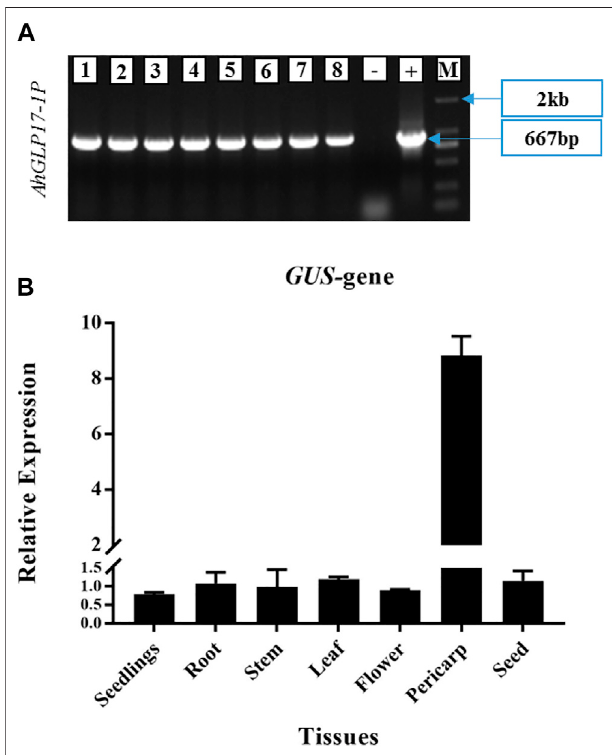
FIGURE 5 | (A) Con fi rmation of T0 transgenic Arabidopsis plants transformedwith AhGLP17-1P (667 bpfragment).Eighthygromycin-resistant plants veri fi ed by PCR ampli fi cation with promoter-speci fi c forward and GUS gene speci fi c reverse primer. Arabidopsis Col-0 was used as – ve control, and Gateway LR constructs were used as + ve control for PCR veri fi cation. M shows 2 kb marker, (B) Quantitative expression of GUS gene